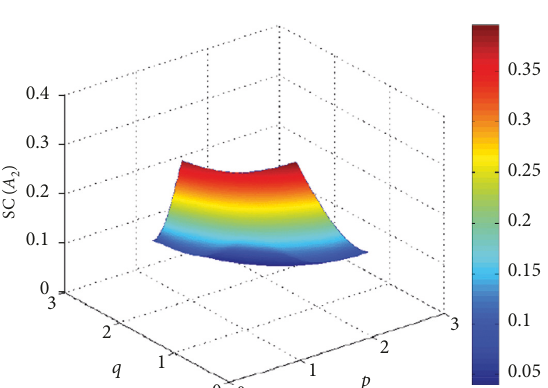
Figure 12: SC ( F and the A-HF2TLWGBM operator.